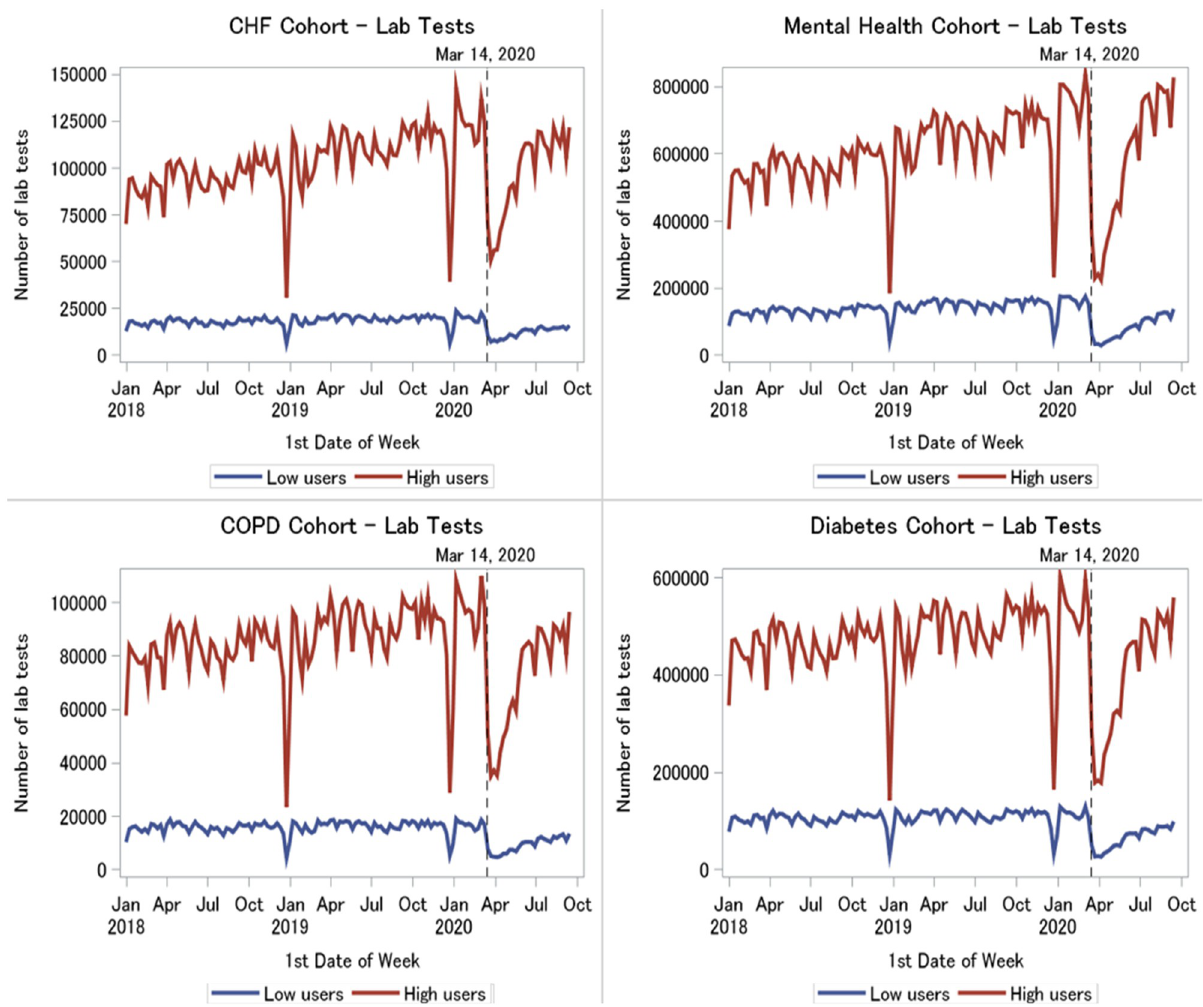
Fig 5. Weekly laboratory testing in high versus low virtual care users by medical condition, January 2018 to September